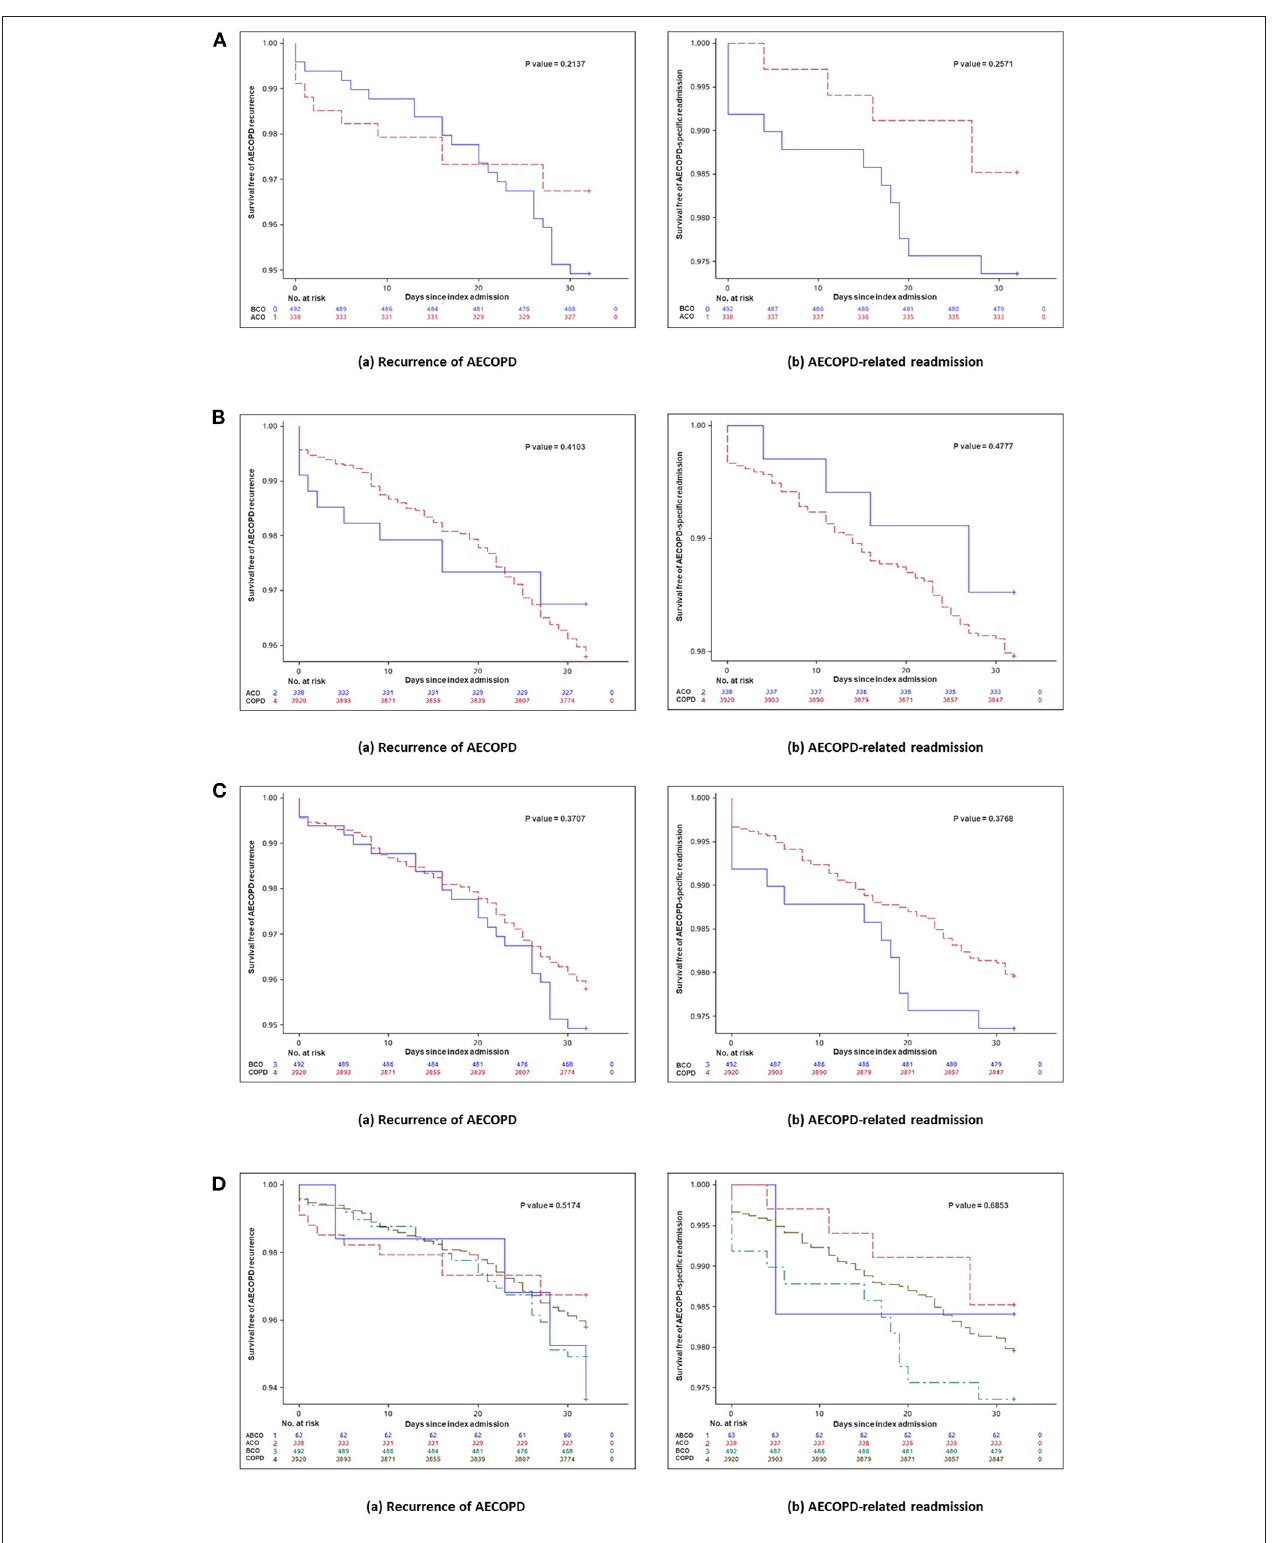
FIGURE 3 | (A) Kaplan–Meier curve and log-rank test for day 30 outcomes between ACO and BCO phenotypes in hospitalized patients with AECOPD. Kaplan–Meier curve and log-rank test for day 30 outcomes (a) recurrent exacerbation ( P = 0.2137) and (b) exacerbation-related readmission ( p = 0.2571) between ACO and BCO phenotypes in hospitalized patients with AECOPD. (B) Kaplan–Meier curve and log-rank test for day 30 outcomes between ACO phenotype and patients without